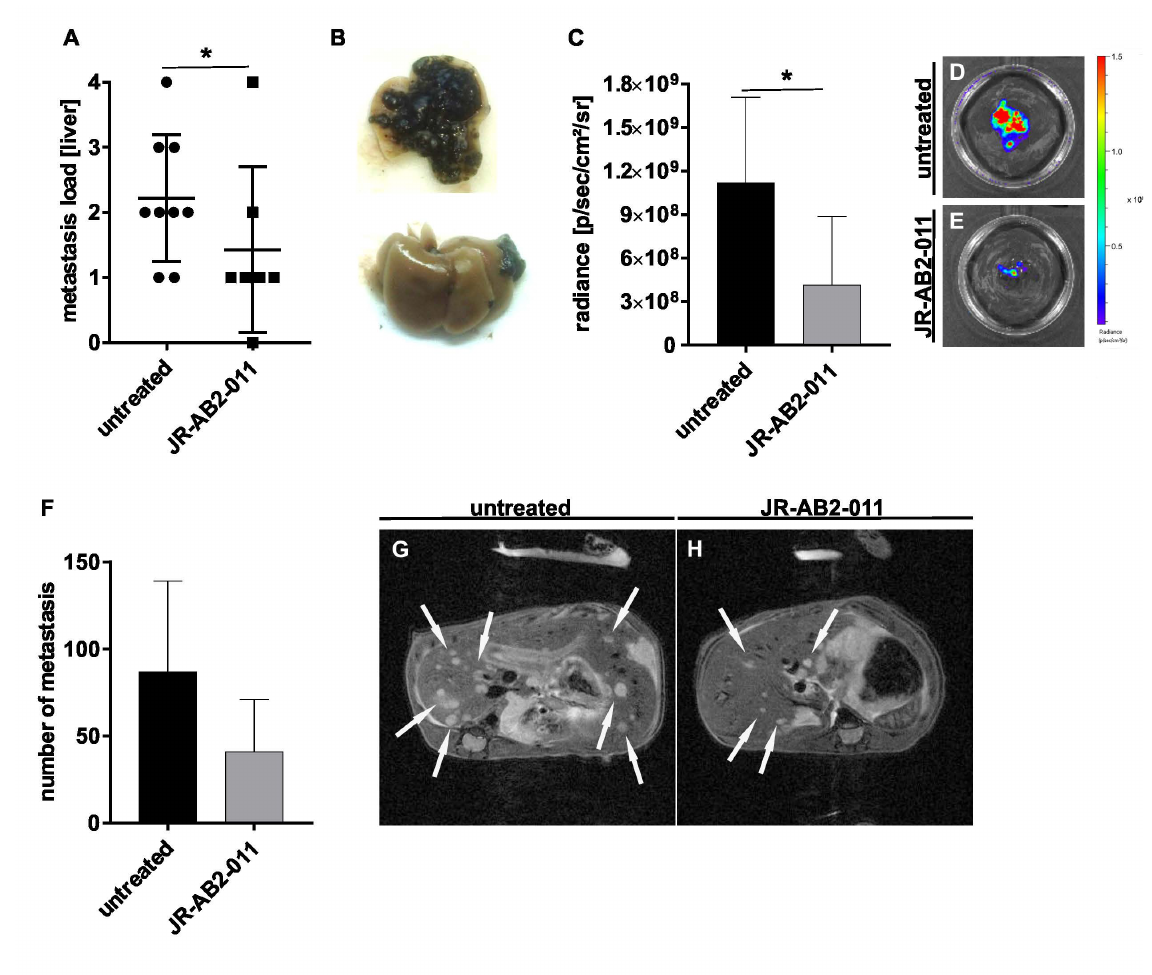
Figure 5. Pharmacological inhibition of mTORC2 reduced the metastasis load in the liver of a syngeneic mouse model. The reduction of the metastasis load in the liver after treatment with JR-AB2-011 was investigated by a mouse model with a splenic injection of B16 murine melanoma cells. The load of total metastasis of untreated controls and treated animals was macroscopically scored after dissection (0 = no tumor load; 1 = very low tumor load; 2 = low tumor load; 3 = medium tumor load; 4 = high tumor load) and indicates a significant reduction of total metastasis ( p = 0.01) ( n = 16) ( A ). Representative images ( B ) show the characteristic of classification type 4 (up) and type 1 (down). Due to the use of luciferase-marked B16 cells, the radiance of the metastasis in the murine liver was measured by bioluminescence imaging and found statistically significant ( p = 0.01) ( n = 16) ( C ). Asterisks (* p ≤ 0.05) indicate significance between treatment and untreated control. Representative images of BLI measurement show the radiance of the dissected liver of untreated ( D ) and treated mice ( E ). The number of single metastasis in the liver was assessed and quantified by MRI measurement with 30 slices, covering the whole liver ( p = 0.25) ( n = 6; 3/group) ( F ). White arrows in representative images of MRI show exemplary metastasis of untreated ( G ) and treated mice ( H